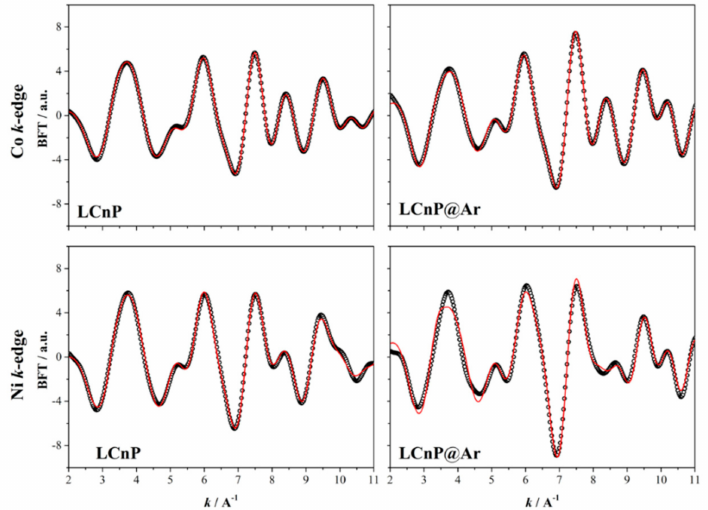
Figure 5. Points and best-fit line for the BFT of the k 3 -weighted Co and Mn K-edge signal for samples LCmP and LCmP@Ar.